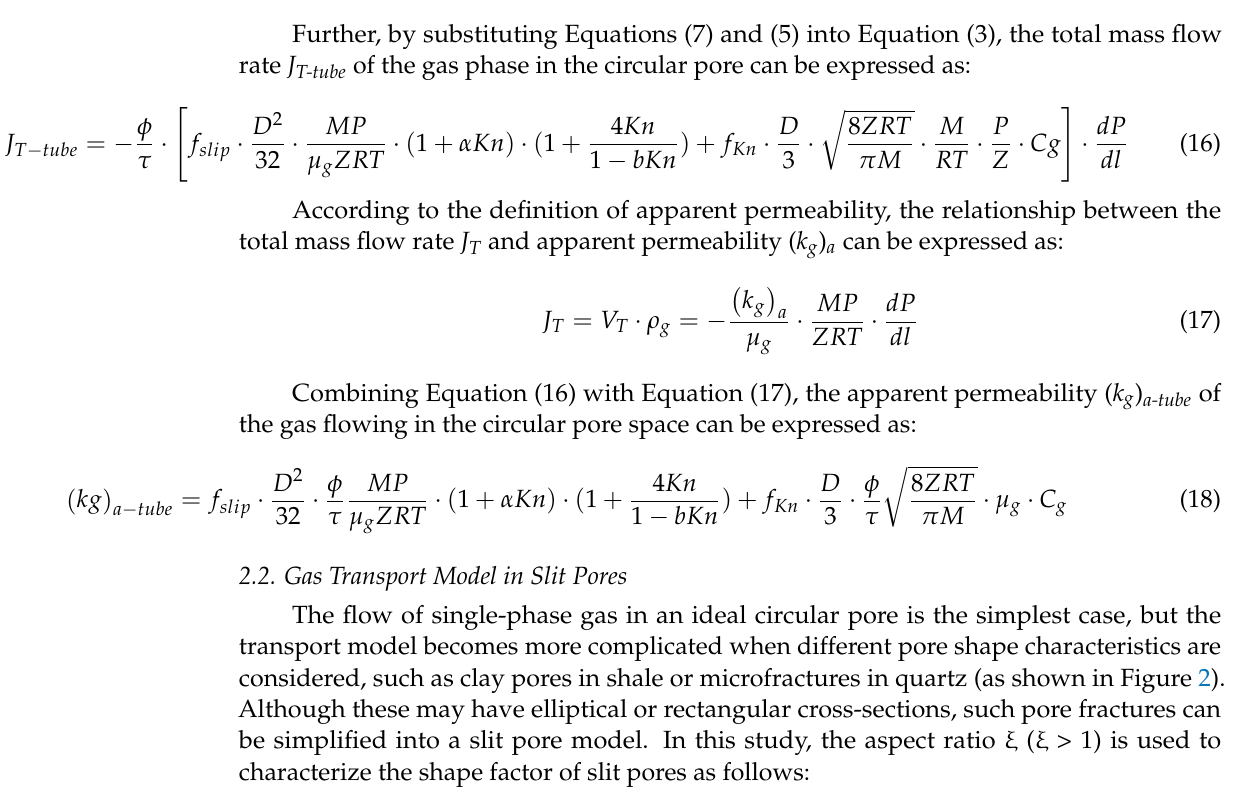
Figure 3. Weight coefficients with different Kn in circular